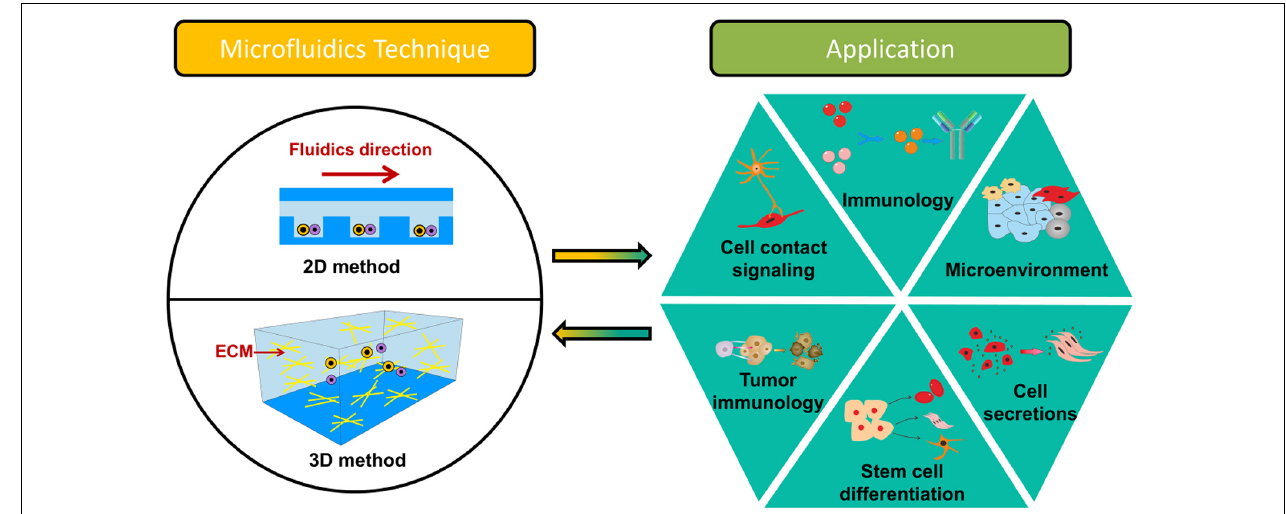
FIGURE 1 | Overview of microfluidics-based systems for intercellular interaction study at the single-cell level.